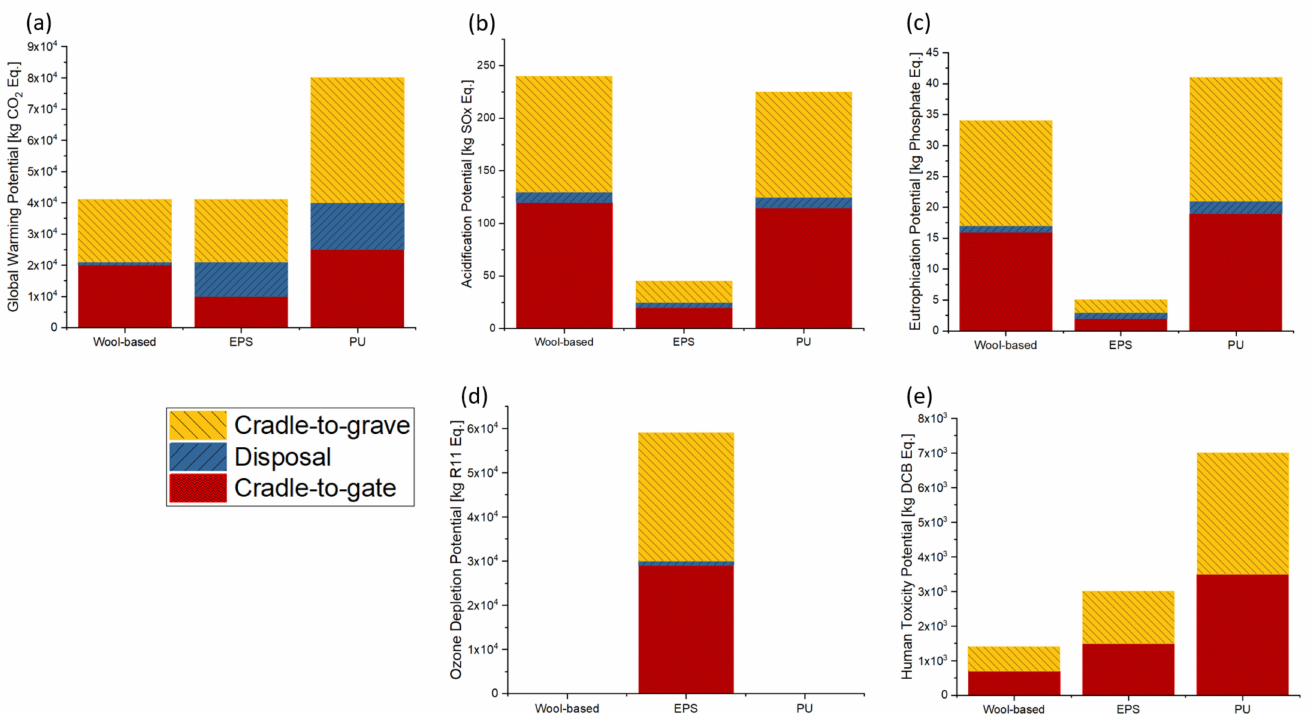
Figure 10. Results of life cycle assessment: ( a ) GWP, ( b ) AP, ( c ) EP, ( d ) ODP, ( e )